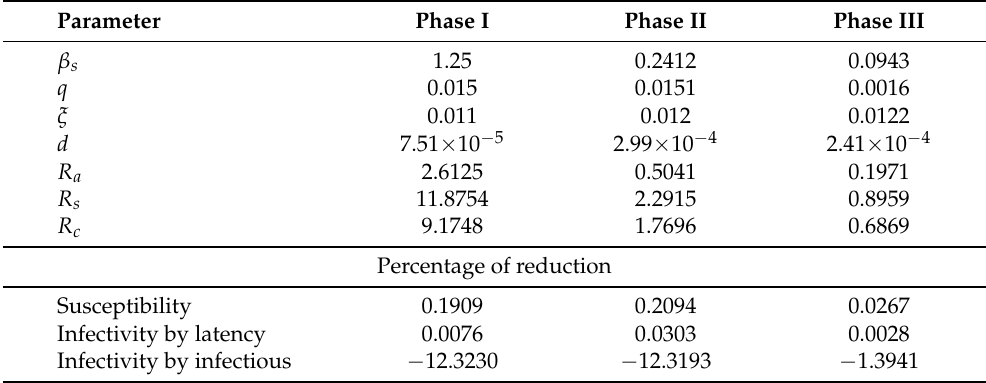
Table 3. Estimation of parameters, the reproduction numbers, and percentage of reduction for the second